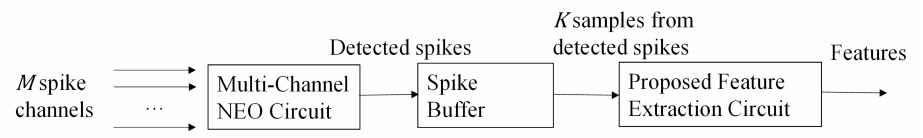
Figure 13. The architecture of a multi-channel spike sorting system based on the proposed feature extraction circuit.